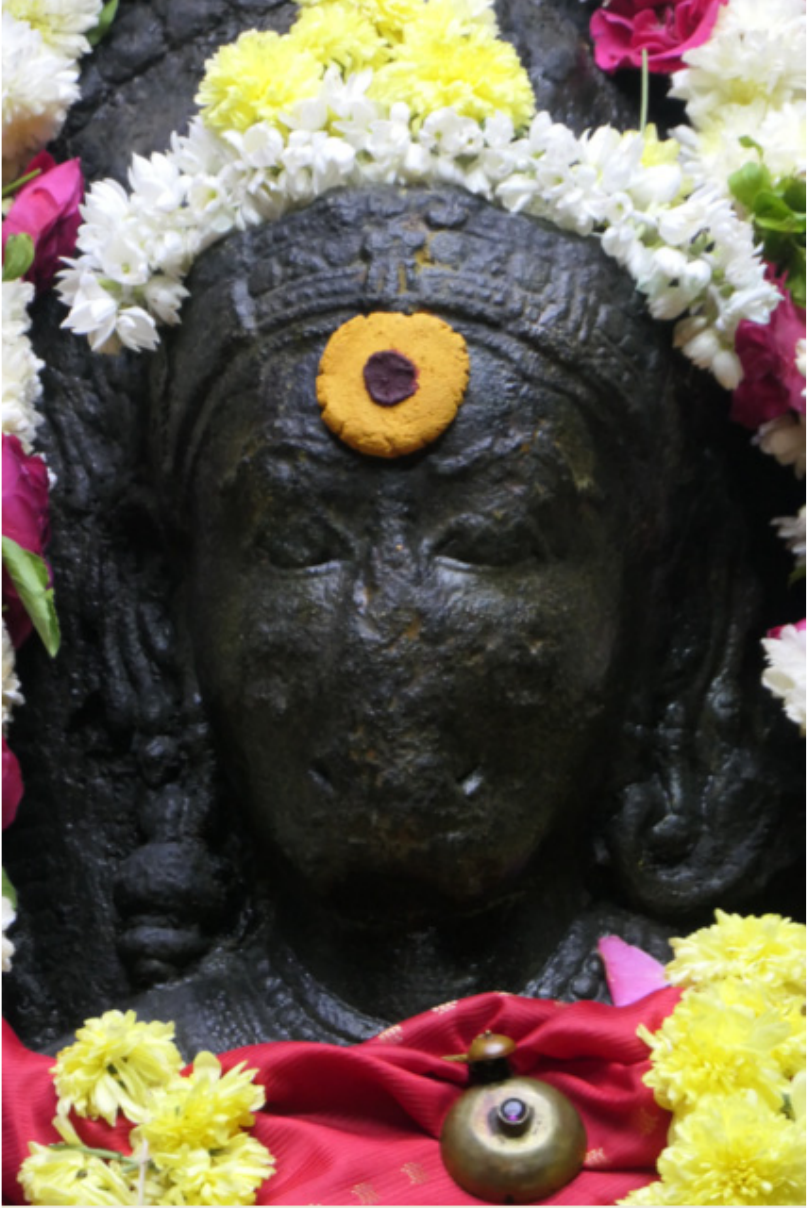
Figure 18. Yogini/Goddess (detail), Kanchi, Tamil Nadu. Photograph by Katherine E. Kasdorf.